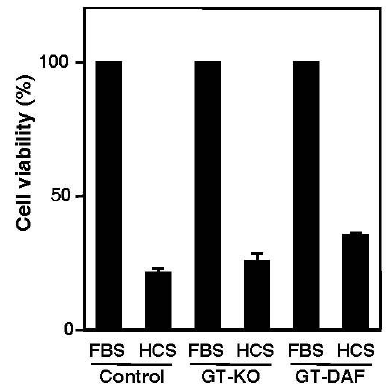
Figure 3. Complement mediated cell lysis in knock-in heterozygous cells. GGTA1 knock-out heterozygous cells (GT- KO) were previously isolated by transfection of GGTA1 knock- out vector into ear fibroblast from miniature pigs. GT-KO is GGTA1 knock-out heterozygous cells and GT-DAF is knock-in heterozygous cells expressing hDAF on GGTA1 locus. The viability in cells treated with 100% human complement serum is compared with 100% survival in the cells treated with 100% FBS. FBS = Fetal bovine serum; HCS = Human complement